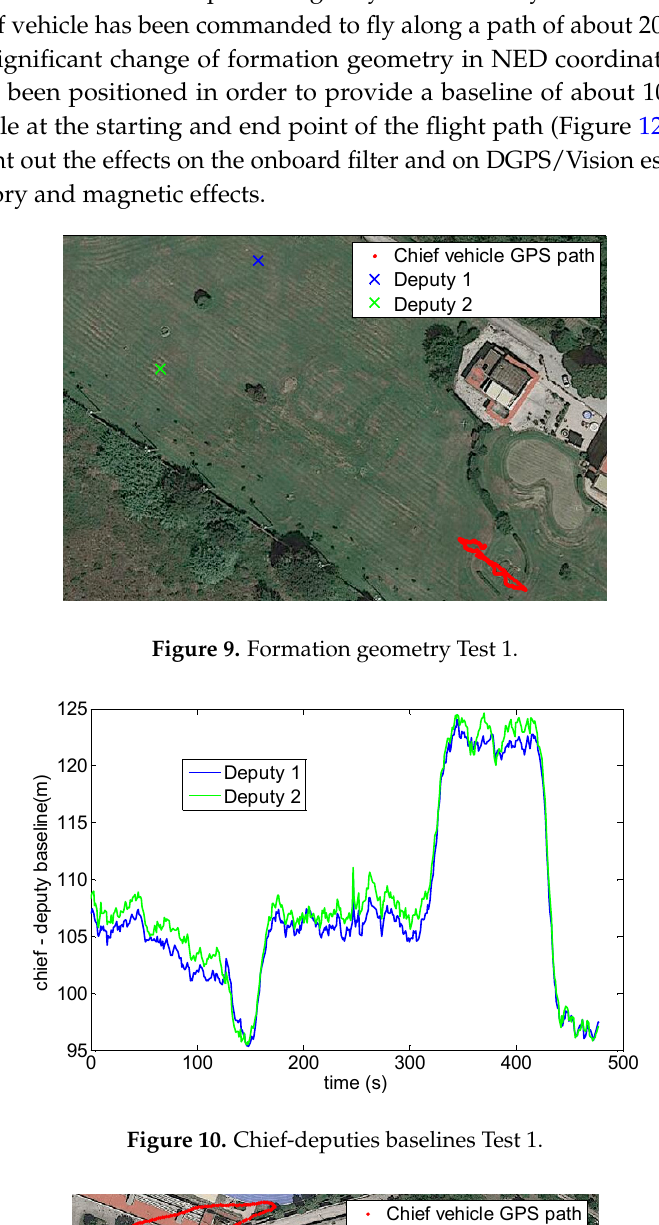
Figure 10. Chief-deputies baselines Test 1.